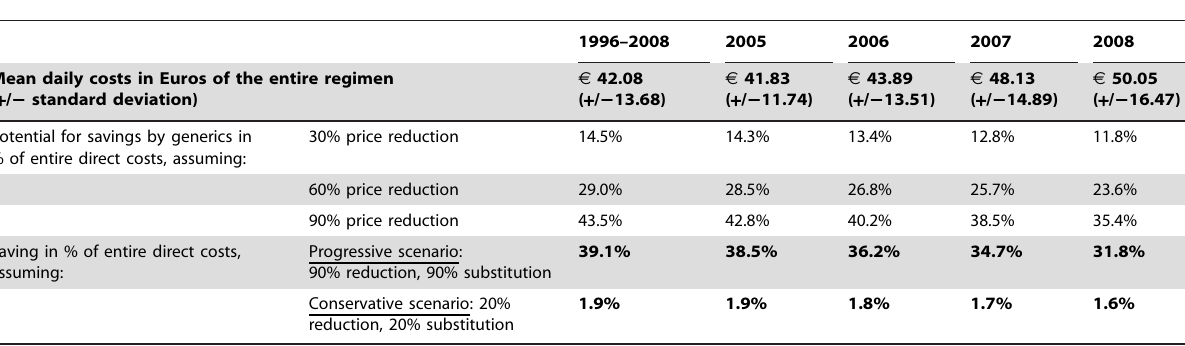
Table 6. Daily costs of antiretroviral therapy components (Euros/per